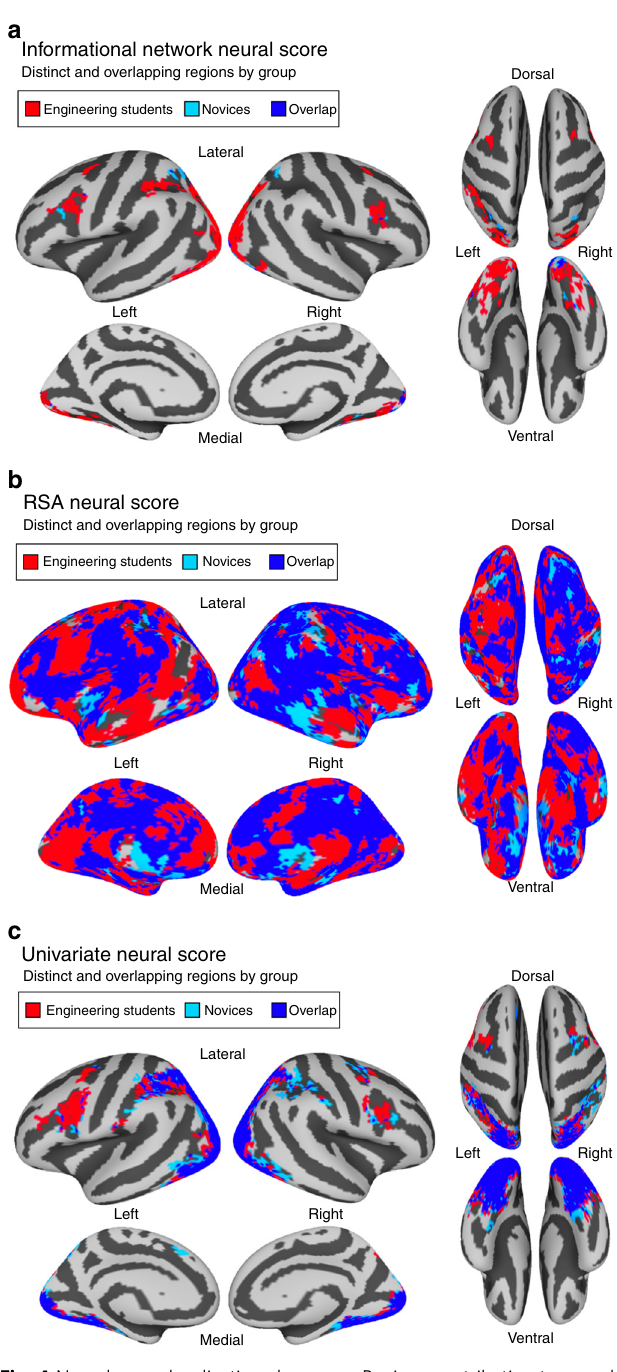
Fig. 4 Neural score localizations by group. Regions contributing to neural scores in engineering students are shown in red. Regions contributing to neural scores in novices are shown in light blue. Regions contributing to neural scores in both engineering students and novices are shown in purple. a , b , and c show the informational network, RSA, and univariate neural score maps,